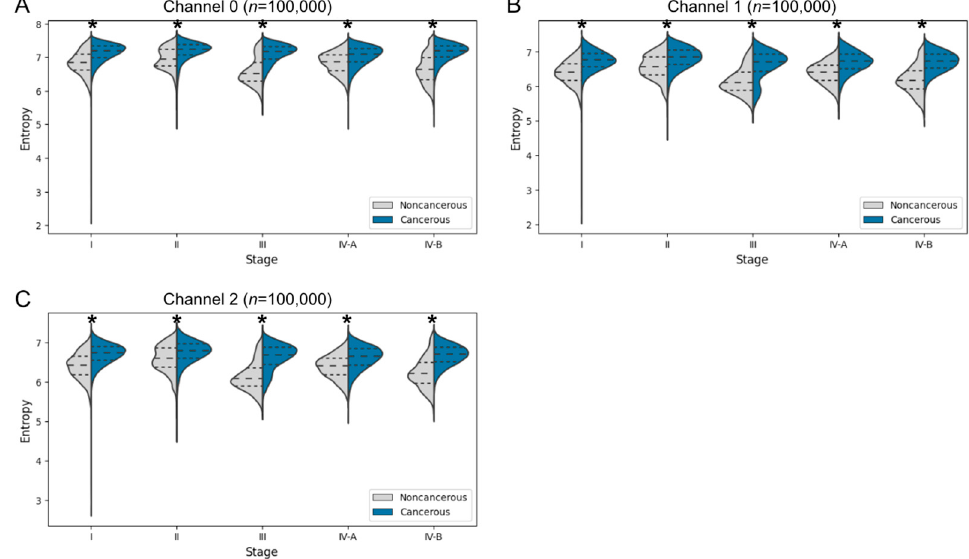
Figure 6. Pixel-wise entropy in red ( A ), green ( B ), and blue ( C ) channels at each cancer stage for cancerous and noncancerous regions of human specimens. Dashed lines indicate the median, and dotted lines the first and third quartiles. * p < 0.001 (Welch’s t -test).